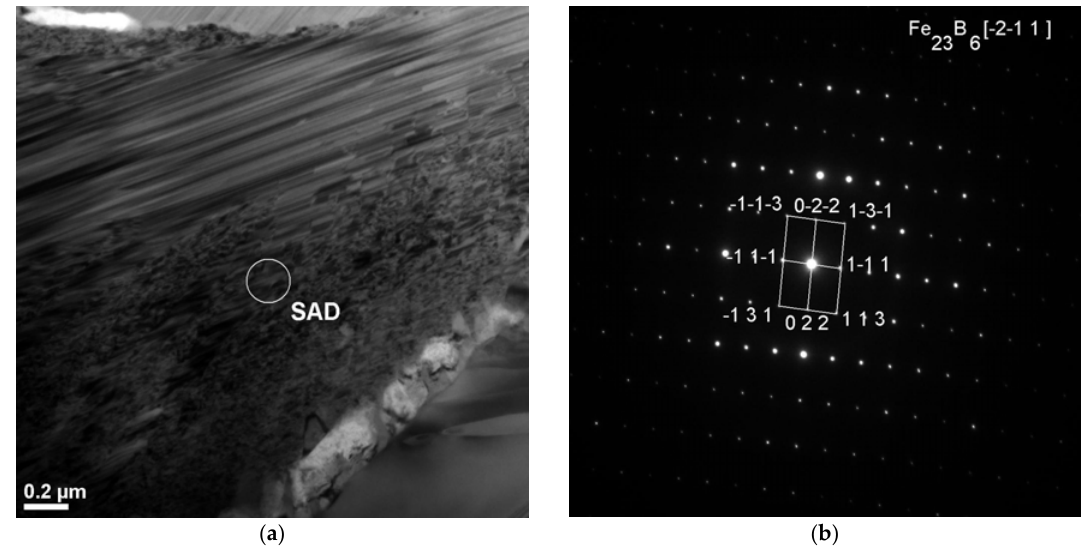
Figure 9. TEM image of the Fe 36.00 Co 36.00 B 19.00 Si 5 Nb 4 alloy in rod form with the diameter of 2.5 mm, ( a ) bright field; ( b ) the electron diffraction from the position marked SAD in (a); solution of diffraction: Fe 23 B 6 phase.